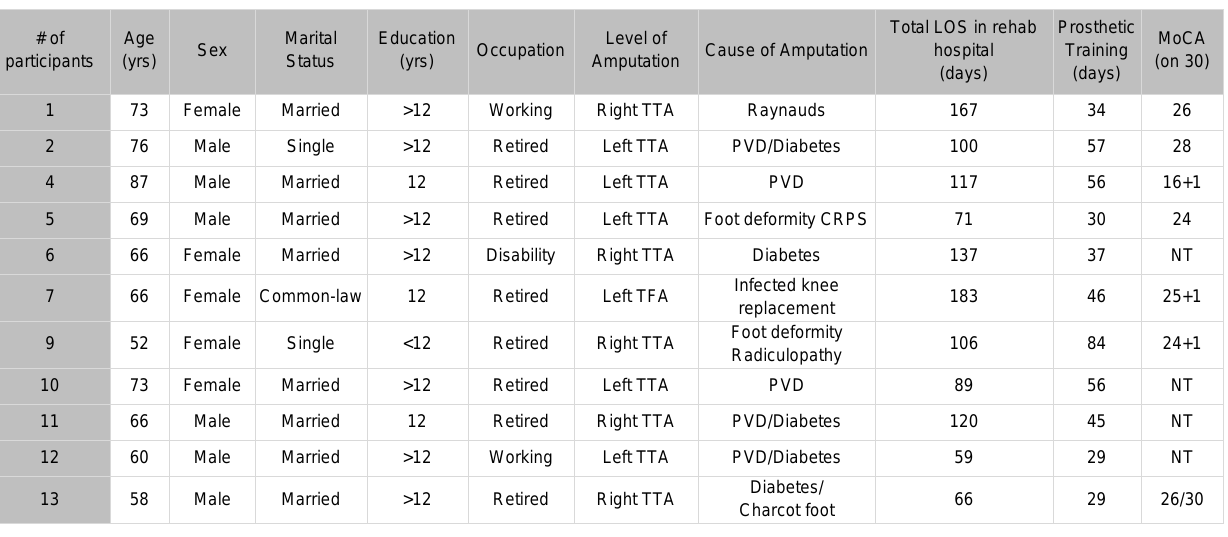
Table 1: Clinical and sociodemographic characteristics of the